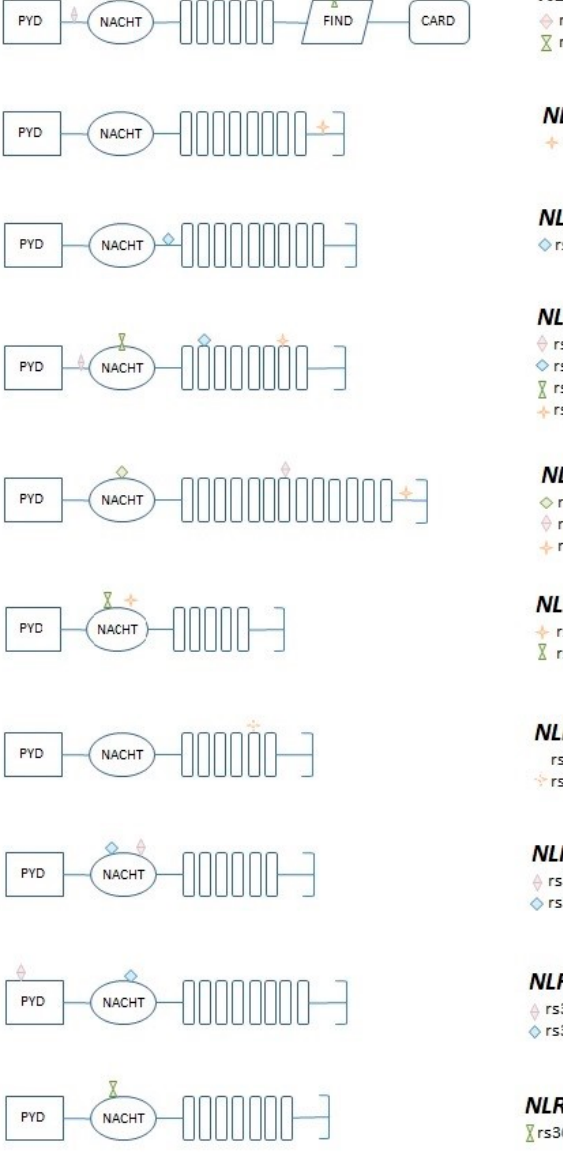
Figure 1. The structure of the selected NLRP genes, the localization of the genotyped SNPs, and their predicted functional consequences according to SIFT and PolyPhen, respectively.